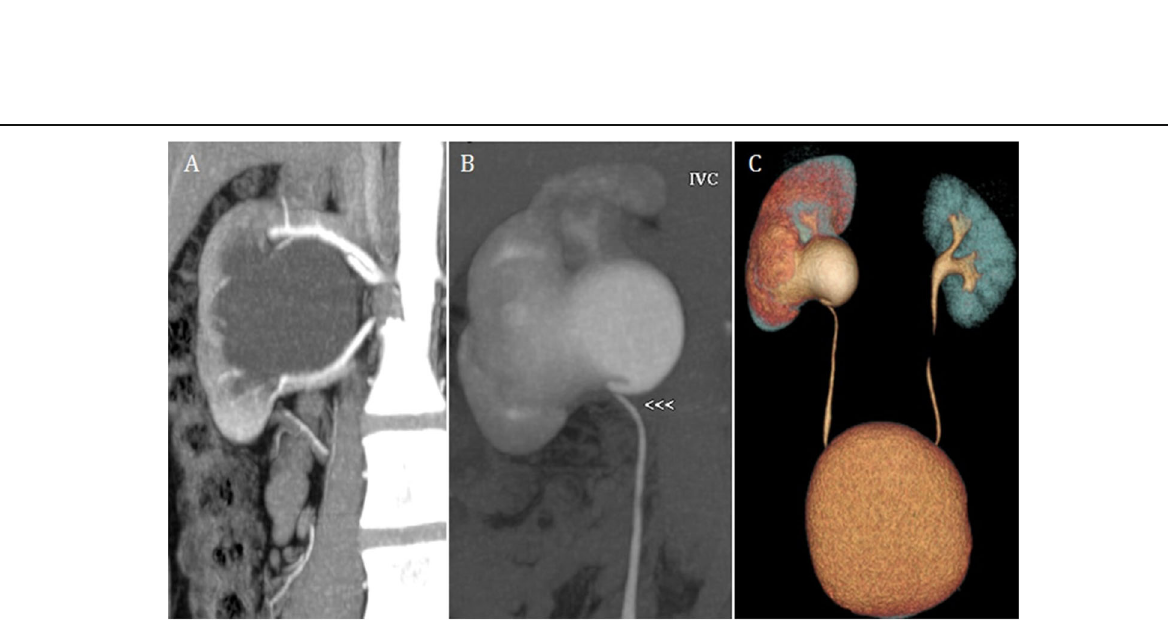
Fig. 9 Same case as in Fig. 8 with PUJ obstruction. Coronal reformatted MIP image ( a ) in the arterial phase shows the main and accessory right renal arteries seen superior and inferior to the dilated pelvis, respectively. Coronal reformatted MIP image in the delayed phase ( b ) and volume- rendered 3D image ( c ) shows the site of PUJ obstruction (arrow) with secondary